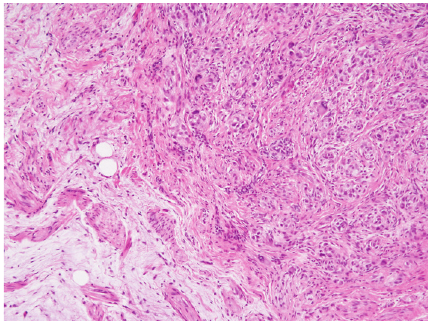
Figure 2: Histopathological findings. Cellular areas composed of histiocyte-likecellsandspindledfibroblast-likecellsattheperiphery (hematoxylin and eosin stain; × 200